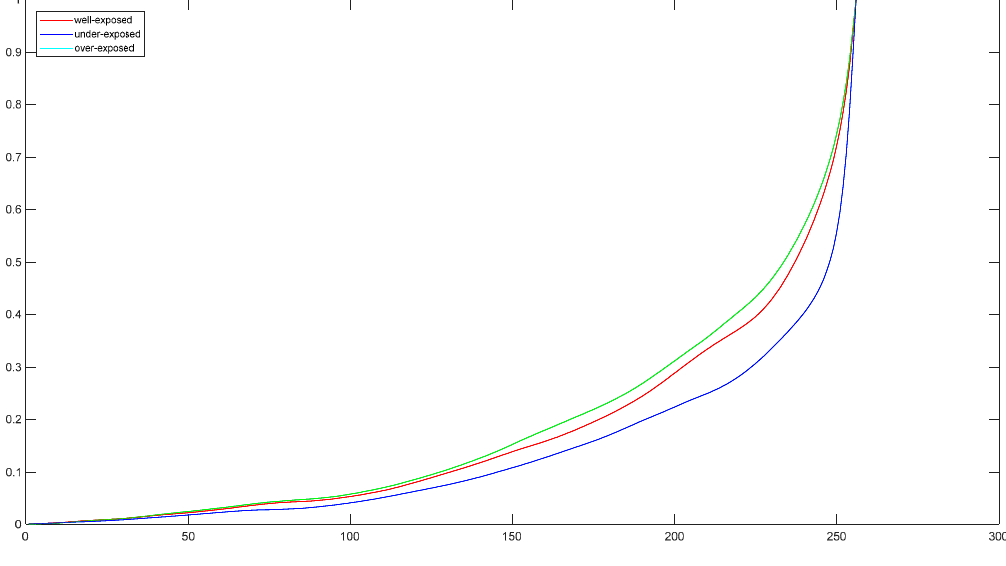
Figure 9. The reverse camera response function (CRF) for red, green, and blue bands for the Figure 1 dataset.